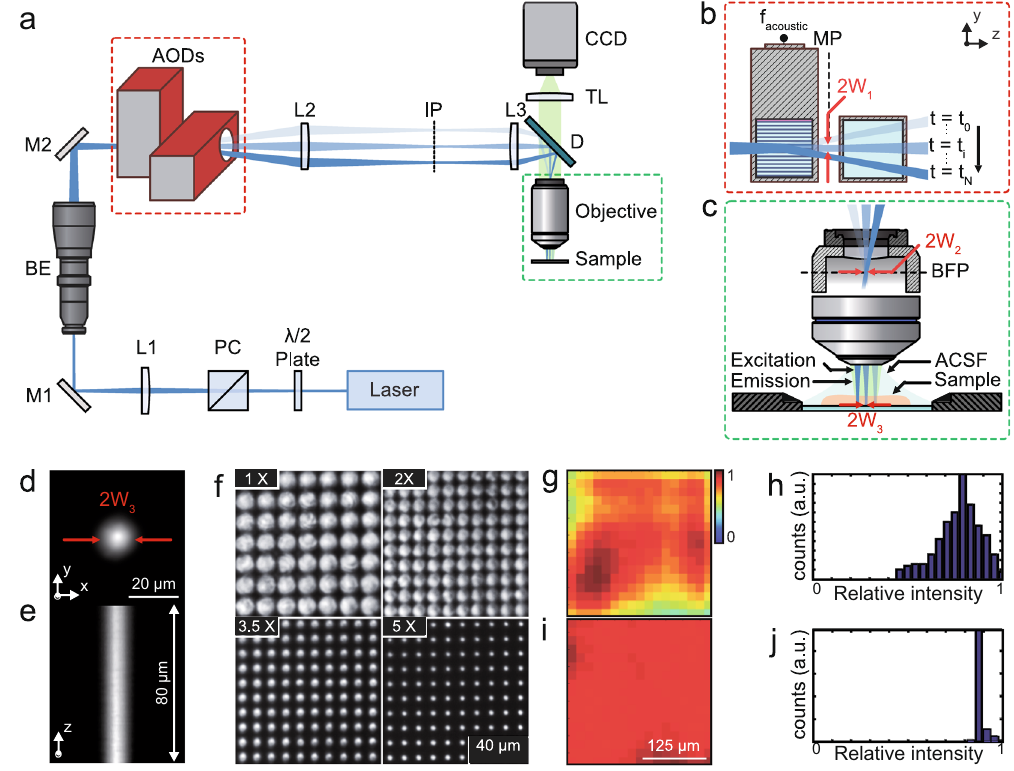
Figure 1. Schematic of the optical setup and characterization. ( a ) A half-wave ( λ /2) plate and a polarizer cube (PC) modulate the laser power and assure linear polarization necessary for the correct functioning of the AODs. The lens L1 focuses the beam on the AOD medial plane (MP) after passing through a variable beam expander (BE) that controls the beam waist. The beam is then relayed onto the objective rear aperture by the lenses L2 and L3. The resulting magnification underfills the objective back aperture producing a large excitation volume at the sample plane. Emitted fluorescence is collected through the same objective and imaged on a CCD camera through a tube lens (TL). ( b ) The beam is focused at the AOD medial plane (MP) and laterally deflected according to the acoustic frequency (f acoustic ) driven into the AODs. ( c ) The MP is imaged at the objective back focal plane (BFP) so all beams exiting the objective are parallel to the optical axis. ( d , e ) Lateral and axial fluorescence intensity distribution at the sample, respectively. ( f ) Spot size at the sample plane corresponding to different magnification values of the beam expander. ( g ) The diffraction power depends in a nonlinear way on the deflection angle. This leads to non-homogeneous power distribution. ( h ) Histogram of the power distribution. ( i ) The power distribution was characterized and dynamically equalized by power modulation of the acoustic signal. ( j ) Histogram of the power distribution after equalization. Abbreviations: TL: tube lens; ACSF: artificial cerebro-spinal fluid; W: beam waist; IP: intermediate